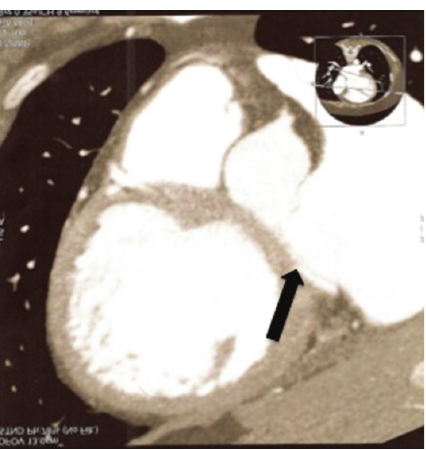
Figure 1: Cardiac CT demonstrating aortic right ventricular fistula.